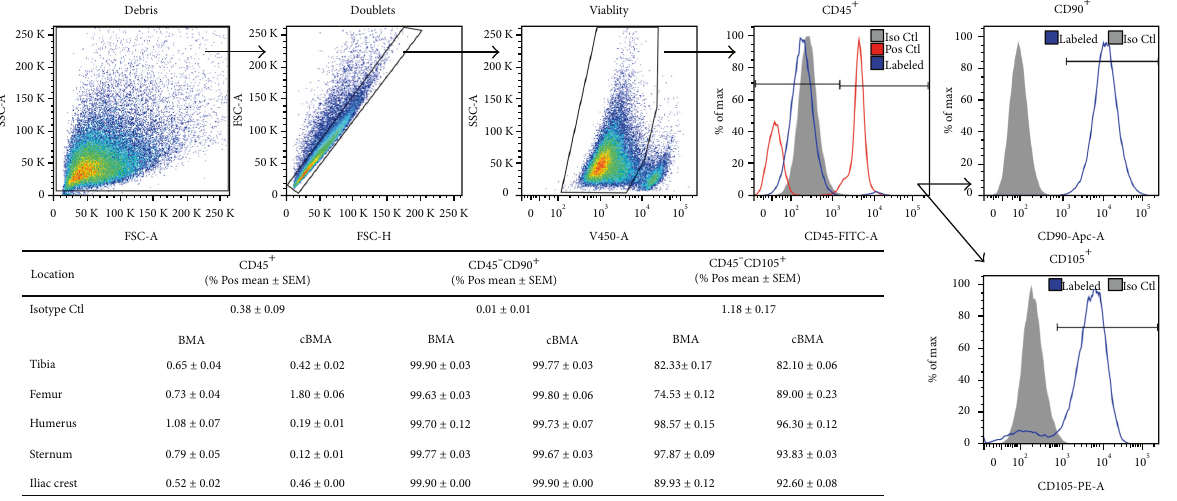
Figure 3: Mesenchymal stem cell surface markers (CD45 − , CD90 + , and CD105 + ) of cells isolated from multiple bone marrow sites before and after